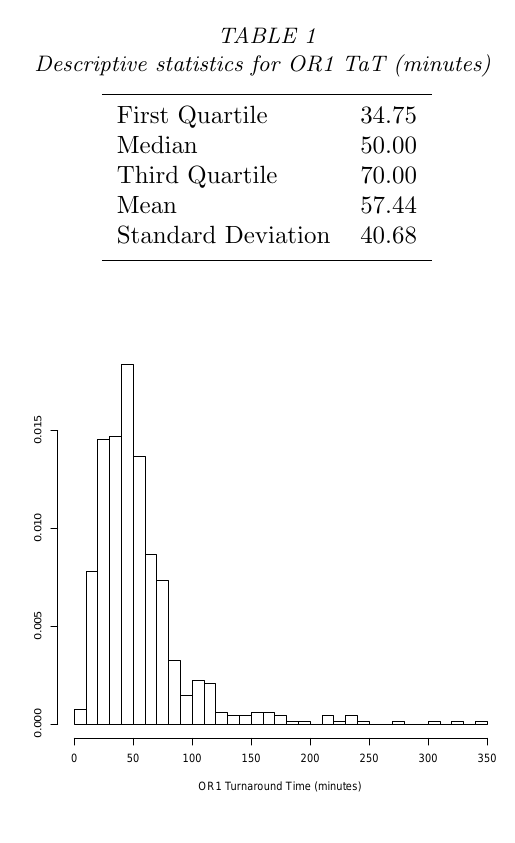
Descriptive statistics for OR1 TaT (minutes)